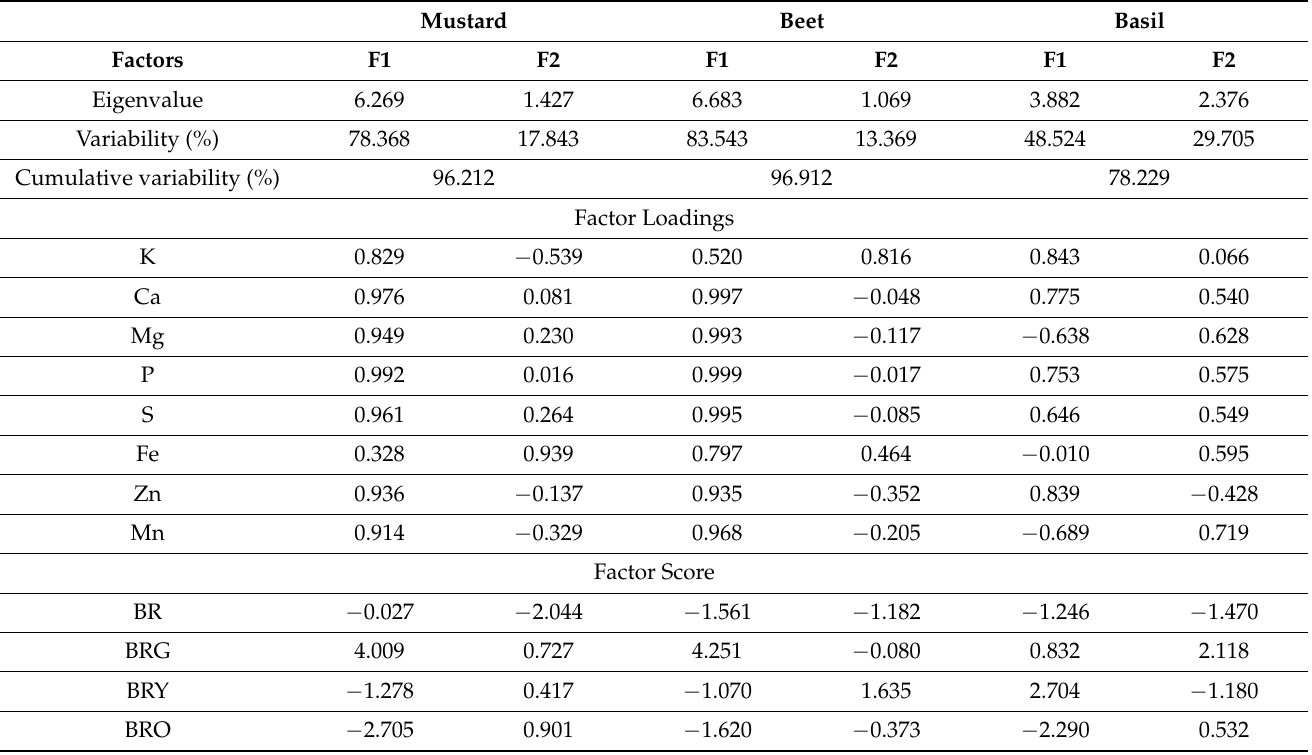
Table 2. Factor loadings, eigenvalue, variability (%), cumulative variability (%) and score for the first two principal (F1–F2) components for mineral nutrients in microgreens under different lighting treatments. Mustard